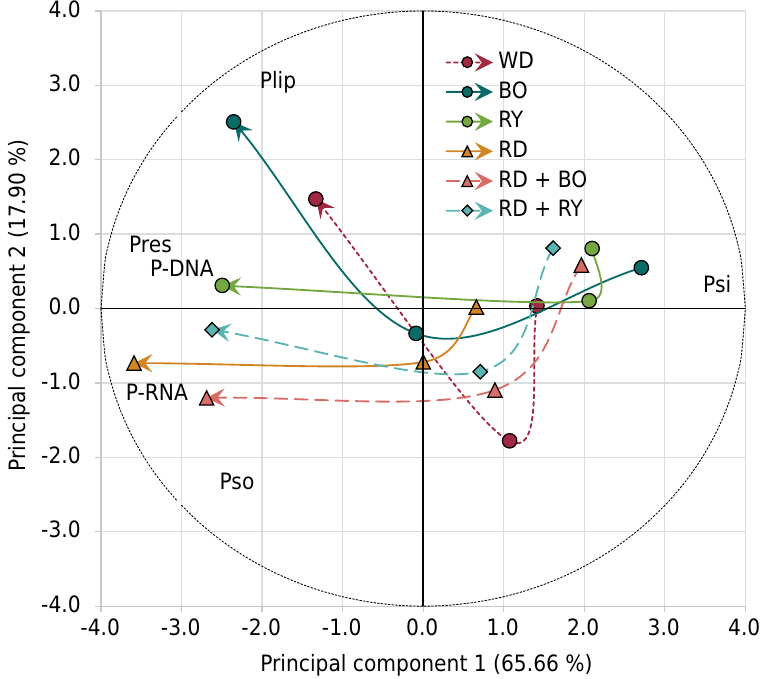
Figure 5. Projection of P forms in the plant residues of weed (WD), black oat (BO), rye (RY), oilseed radish (RD), oilseed radish + black oat (RD + BO), and oilseed radish + rye (RD + RY) at different sampling times. Numbers in parentheses indicate the percentage of variance explained by each axis. The direction of the arrows indicates the sampling times, the first at 0 and then at 15 and 45 days after deposition (DAD) of